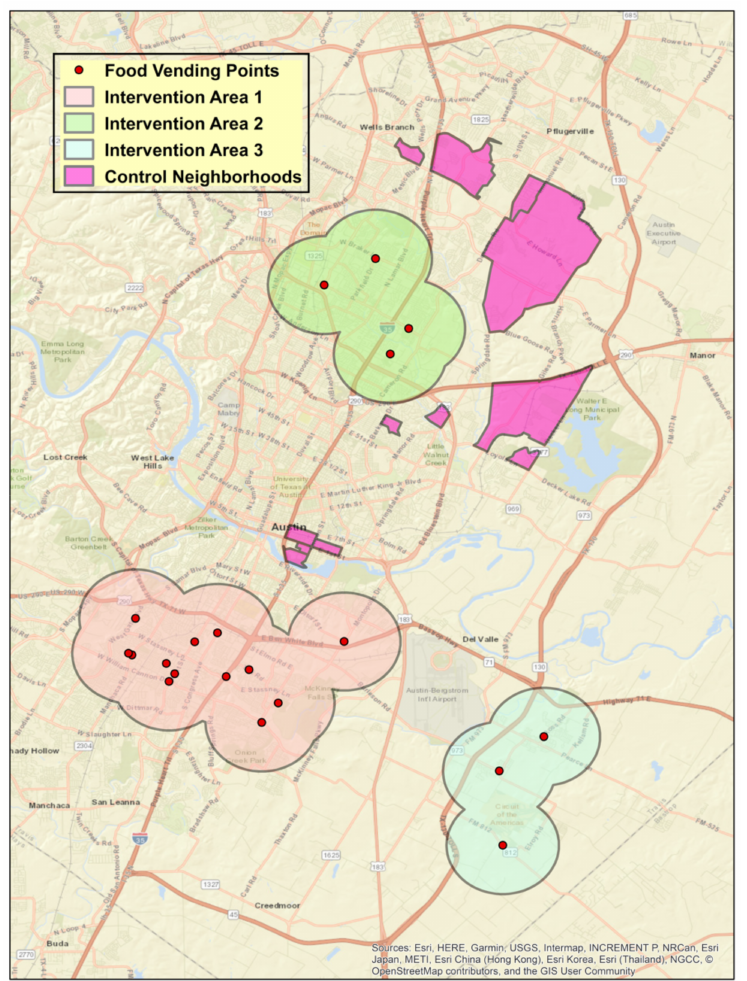
Figure 2. Map of FRESH-Austin Sampling Frame: The above presents the map of the sampling frame for the FRESH-Austin Evaluation study. The red dots are the locations of Fresh For Less assets that were open in 2018 and where the Confirmed Users were recruited. Intervention Areas (1, 2, and 3) are the areas where the Geographically Exposed participants were recruited, as they lived within 1.5 miles (or a 1.5 mile buffer) of an FFL asset. The control neighborhoods are where the Comparison Group participants were recruited, as these census tracts had similar sociodemographic characteristics as the census tracts of the geographically exposed areas, but they did not have an FFL asset within 1.5 miles of their